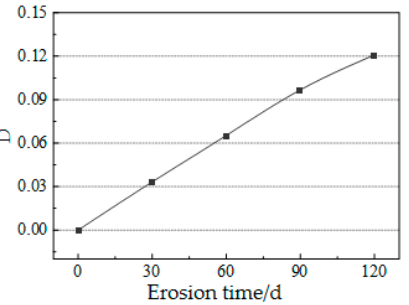
Figure 11. Damage variable of test pieces after sulfate attacks.